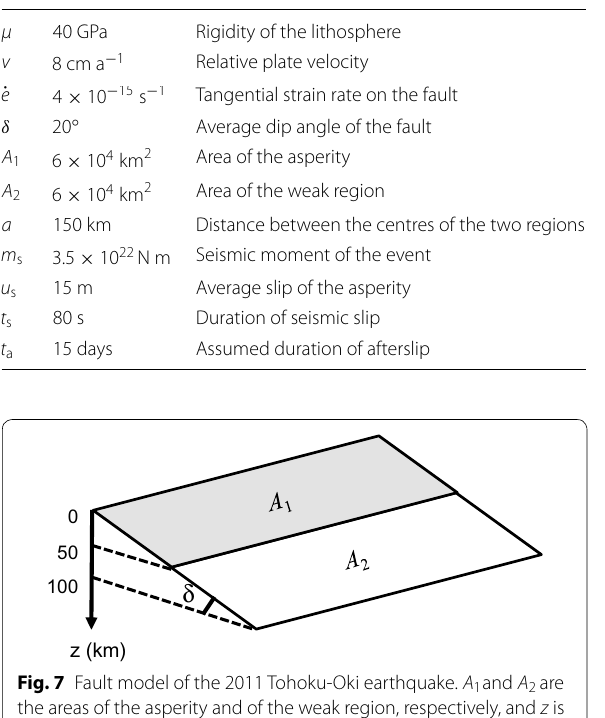
Table 1 Data for the 2011 Tohoku‑Oki earthquake Table 2 Values of model parameters for the 2011